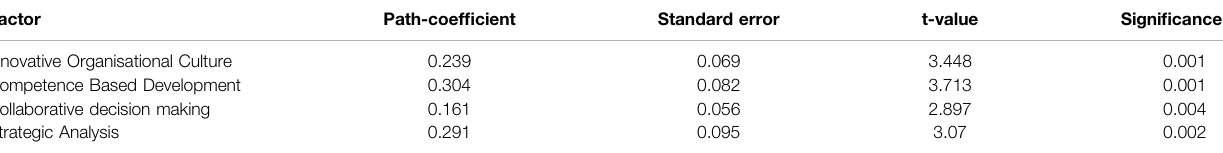
TABLE 9 | Regression coef fi